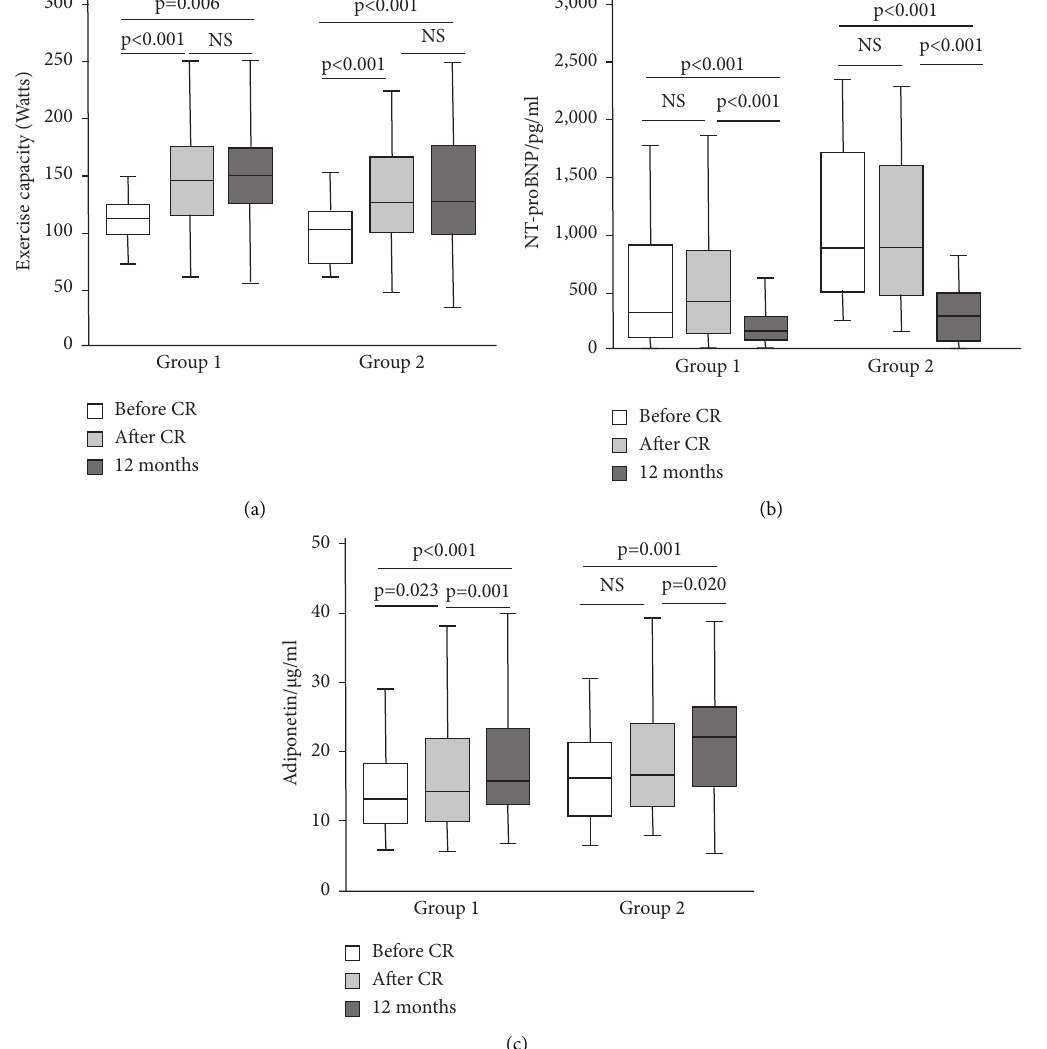
Figure 3: Serial changes in exercise capacity (a), blood level of N-terminal part of the pro-brain natriuretic peptide (NT-proBNP) (b), and adiponectin (c) before and after cardiac rehabilitation as well as at 12-month follow-up in patients divided to group 1 ( n � 54, normal left ventricular function) and group 2 ( n � 27, impaired left ventricular function). The data are expressed in median with quartiles and the minimal and